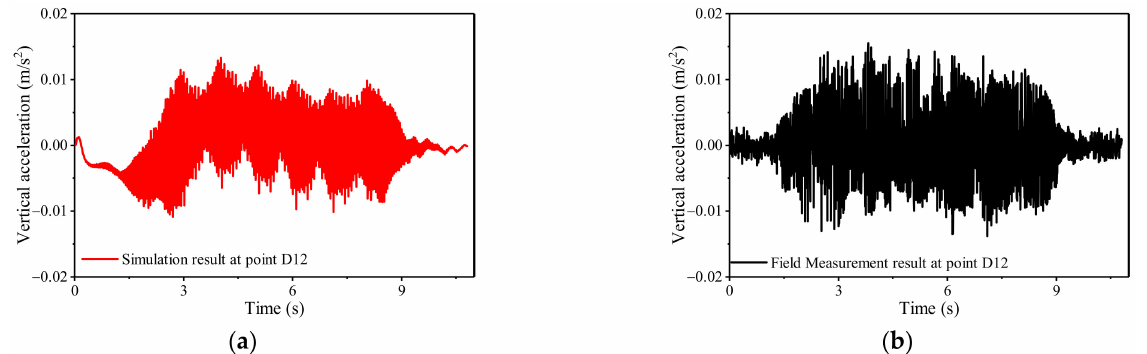
Figure 7. Vertical acceleration at point D11. ( a ) Numerical model result; ( b ) Field measurement result.